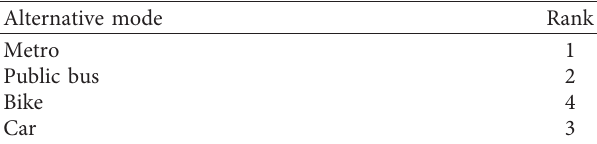
Table 7: Fuzzy TOPSIS results for the respondents. Table